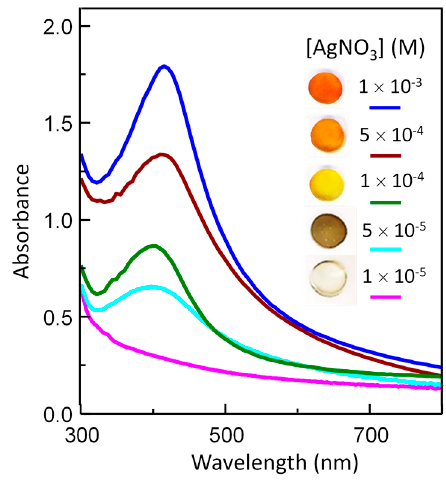
Figure 5. UV-Vis of spectra of Ag–PU PEG 85 hydrogel nanocomposite disks, while increasing the AgNO 3 concentration added to the PU hydrogel disk (Table 3). Inset: Pictures of the resulting Ag–PU hydrogel nanocomposite disks (error bars represent standard deviation for studies conducted in triplicate).